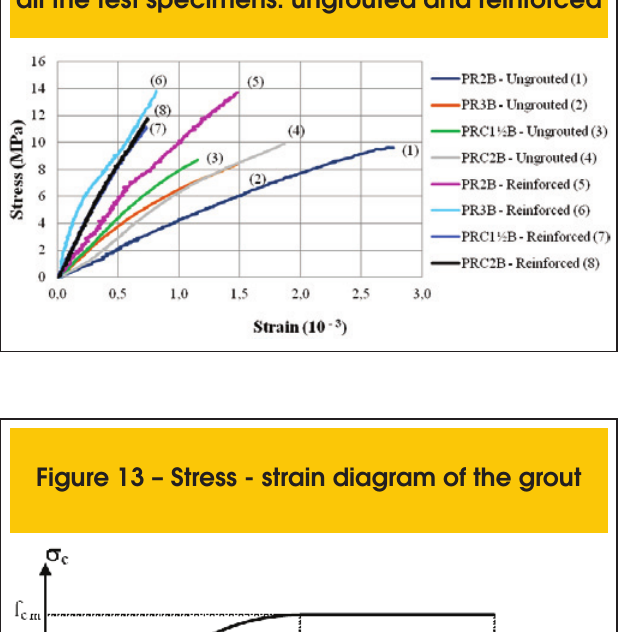
Figure 12 – Mean stress - strain relationship of all the test specimens: ungrouted and reinforced